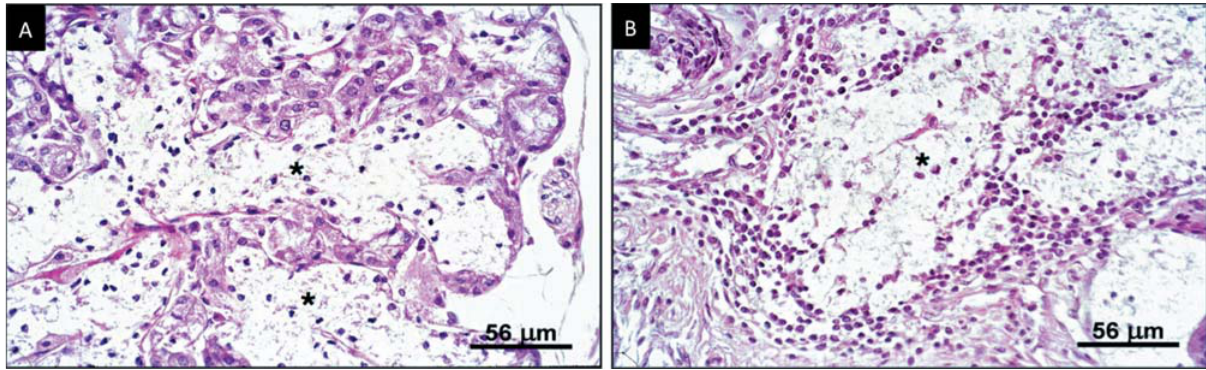
Figure 2- (cid:3)(cid:36)(cid:29)(cid:3)(cid:36)(cid:70)(cid:76)(cid:81)(cid:68)(cid:85)(cid:3)(cid:68)(cid:88)(cid:87)(cid:82)(cid:79)(cid:92)(cid:86)(cid:76)(cid:86)(cid:3)(cid:11)(cid:13)(cid:12)(cid:15)(cid:3)(cid:48)(cid:68)(cid:79)(cid:72)(cid:15)(cid:3)(cid:23)(cid:28)(cid:3)(cid:92)(cid:72)(cid:68)(cid:85)(cid:86)(cid:3)(cid:82)(cid:79)(cid:71)(cid:3)(cid:11)(cid:43)(cid:17)(cid:40)(cid:17)(cid:3)(cid:50)(cid:85)(cid:76)(cid:74)(cid:76)(cid:81)(cid:68)(cid:79)(cid:3)(cid:80)(cid:68)(cid:74)(cid:81)(cid:76)(cid:191)(cid:70)(cid:68)(cid:87)(cid:76)(cid:82)(cid:81)(cid:29)(cid:3)(cid:91)(cid:20)(cid:19)(cid:19)(cid:12)(cid:30)(cid:3)(cid:37)(cid:29)(cid:3)(cid:48)(cid:88)(cid:70)(cid:82)(cid:88)(cid:86)(cid:3)(cid:72)(cid:91)(cid:87)(cid:85)(cid:68)(cid:89)(cid:68)(cid:86)(cid:68)(cid:87)(cid:76)(cid:82)(cid:81)(cid:3)(cid:11)(cid:13)(cid:12)(cid:15)(cid:3)